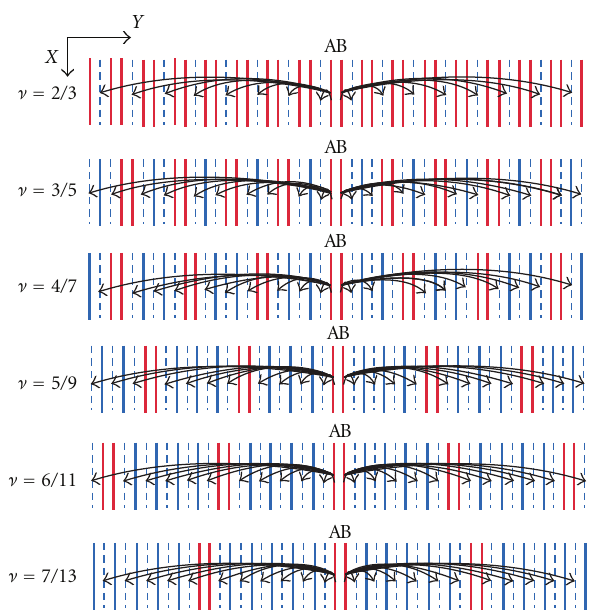
Figure 8: Allowed transitions of nearest electron pair at ν = j/ (2 j − 1).